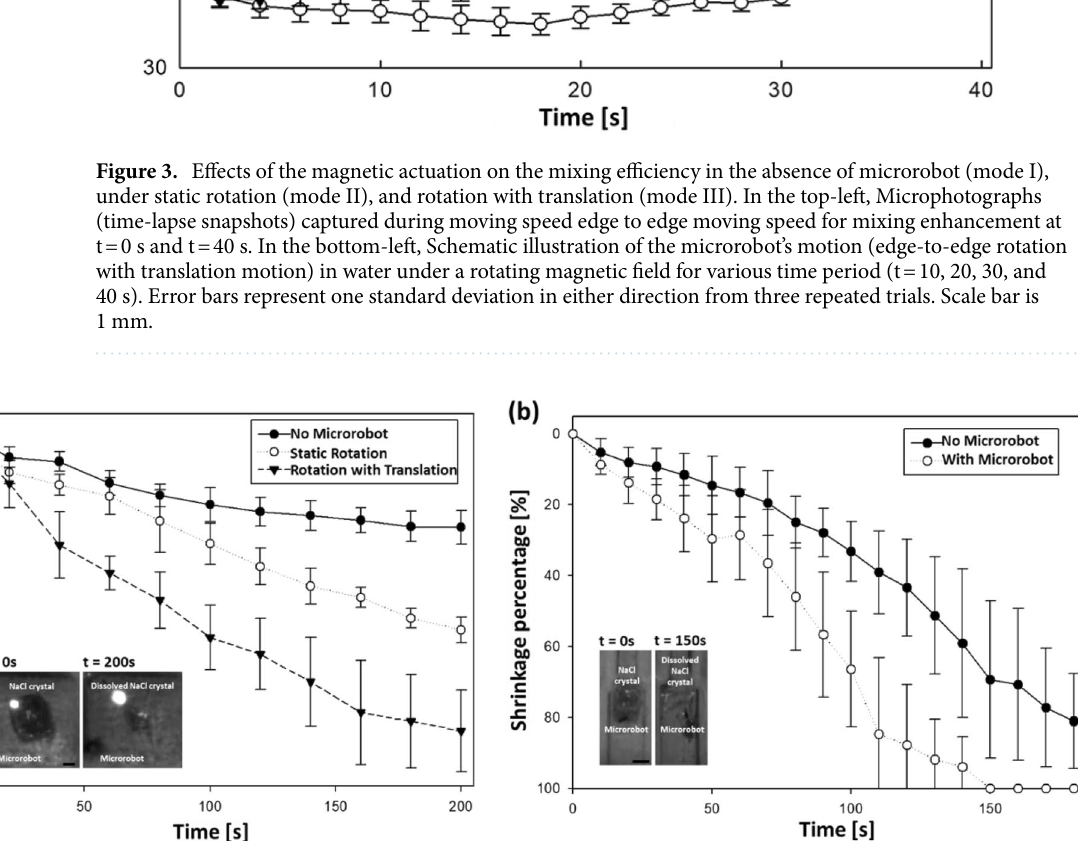
Figure 4. Performance of the microrobot in dissolution of NaCl crystal. ( a ) Shrinkage percentage of NaCl crystal dissolved in an open tank in the absence of microrobot (mode I), under static rotation (mode II), and rotation with translation mode (mode III). Microphotographs (time-lapse snapshots) captured during rotation with translation mode at t = 0 s and t = 200 s. ( b ) Shrinkage percentage of NaCl crystal dissolved in the closed channel in the absence of microrobot, and with microrobot. Microphotographs (time-lapse snapshots) captured during the second mode (with microrobot) at t = 0 s and t = 150 s. Error bars represent one standard deviation in either direction from three repeated trials. Scale bar is 1 trated in Fig. 4b for the closed channel, the average shrinkage rate (at t = 150 s) was 0.450% without microrobot, while the shrinkage rate was 0.667% with microrobot. The SDs showed an increasing trend with the increase in shrinkage percentage which was due to the unstable conditions in the fluid environment as the NaCl crystals dissolute and get displaced in the surrounding environment. During the dissolution, the NaCl crystals would initially shrink from the four edges of the tank and form star-liked shape, over the time the crystals breakdown into irregular shapes while reaching the end of the process (See Supplementary Video 3 and 4). As illustrated